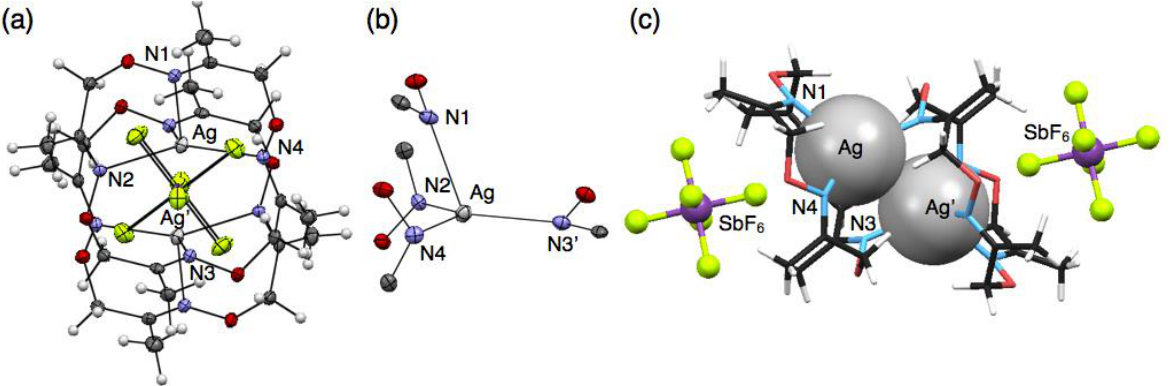
Figure 3. Crystal structure of [Ag structure represented with 50% thermal ellipsoids; ( c ) A side view represented with space fill (Ag), stick ( 1 ) and ball-stick (counter anions) models.